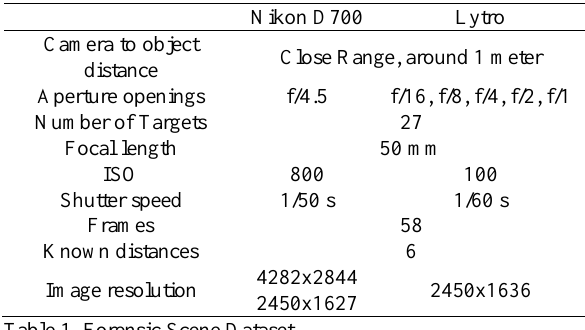
Table 1. Forensic Scene Dataset